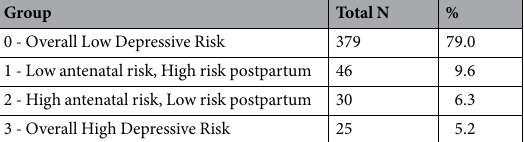
Table 1. Distribution of the cohort within created Group variables.